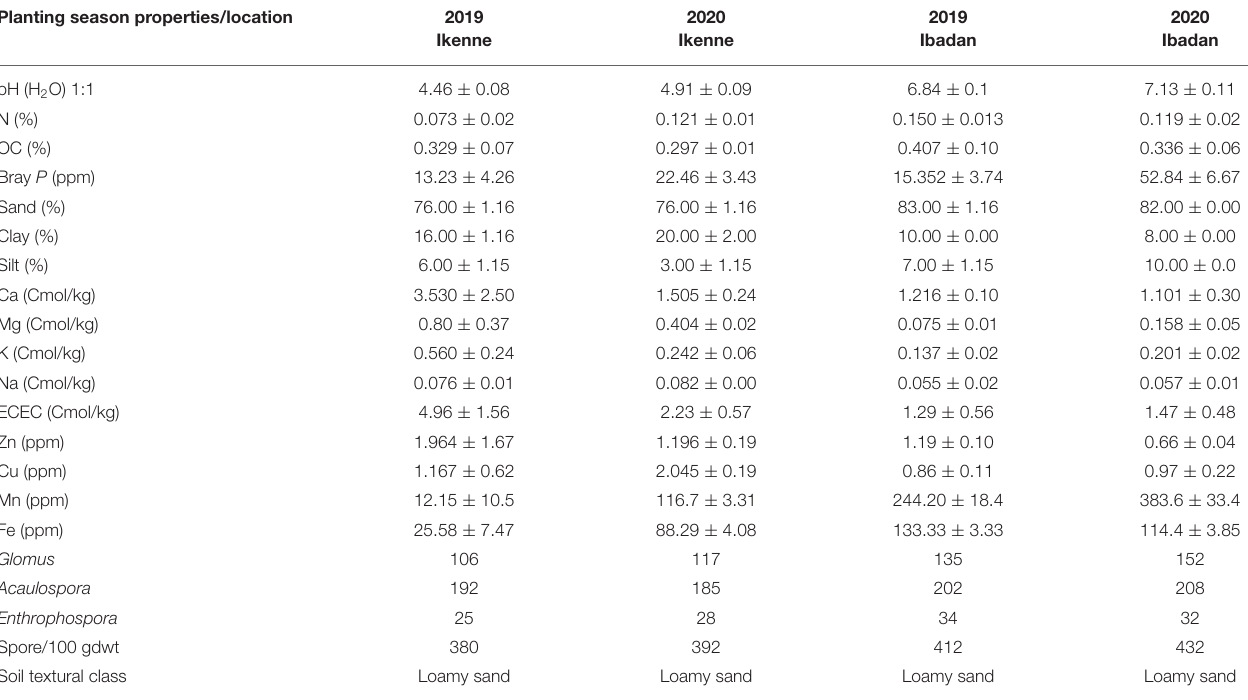
TABLE 1 | Physiochemical and biological properties of soil used for the studies. Planting season